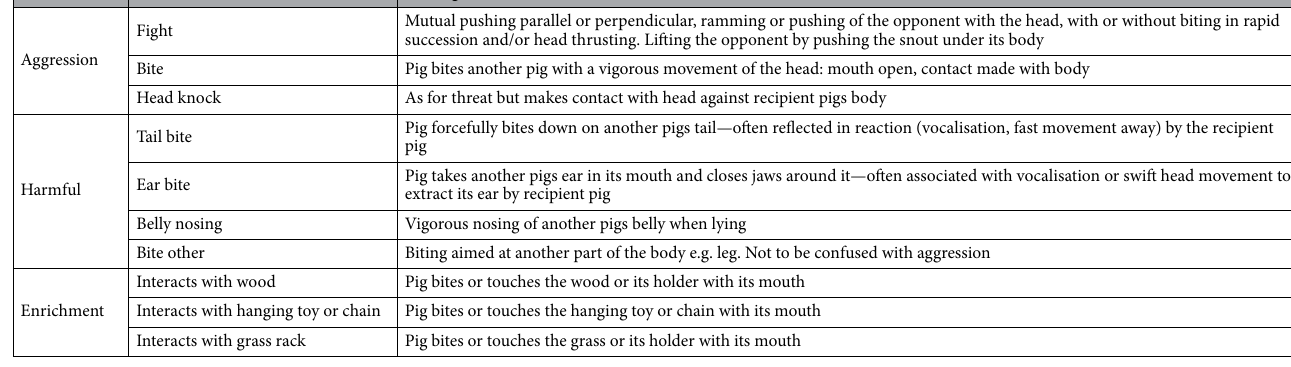
Table 1. Ethogram of pig